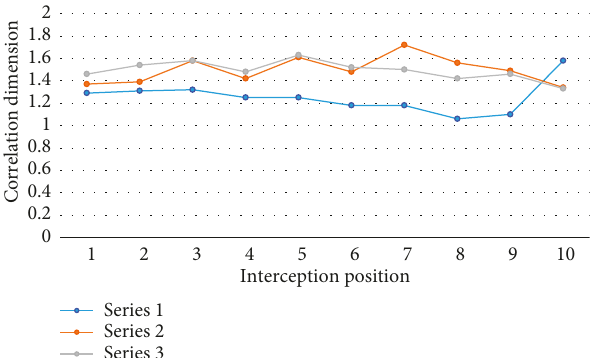
Figure 11: Correlation dimension values of vibration signals intercepted at different